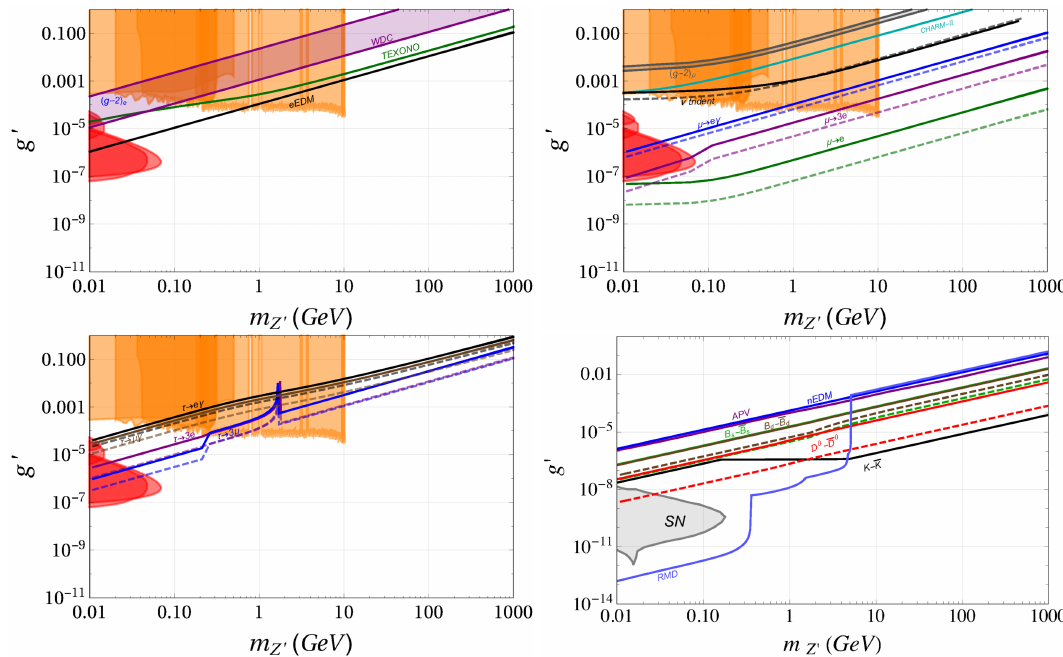
JHEP02(2022)033 Figure 2 . The top panels and bottom left (right) panel show bounds on the Z 0 mass and the g 0 gauge coupling constant for the G FN = U(1) 0 model benchmark in the limit of no couplings to FN quarks (leptons). Direct Z 0 production searches exclude orange and red regions, cf. figure 1. Top left : bounds involving electrons, from the electron EDM ( ¯ ν e − e scattering, ( g − 2) e , white dwarf cooling), shown as black line (green line, blue line, purple excluded region). Top right : bounds involving muons, from µ → e conversion, ( µ → 3 e , µ → eγ , neutrino trident production, ν µ − e scattering), shown as green (purple, blue, black, cyan) lines, while the gray region is consistent with ( g − 2) µ . Bottom left : bounds involving taus, from τ → 3 µ ( τ → 3 e , τ → µγ , τ → eγ ) shown with blue (purple, brown, black) lines. Bottom right : bounds involving quarks only, from K − ¯ K mixing ( D − ¯ D , B s − ¯ B s , B d − ¯ B d mixing, neutron EDM, APV, RMD), shown as black (red, green, brown, blue, purple, light blue) lines, while the gray region is excluded by SN1987A. Solid (dashed)